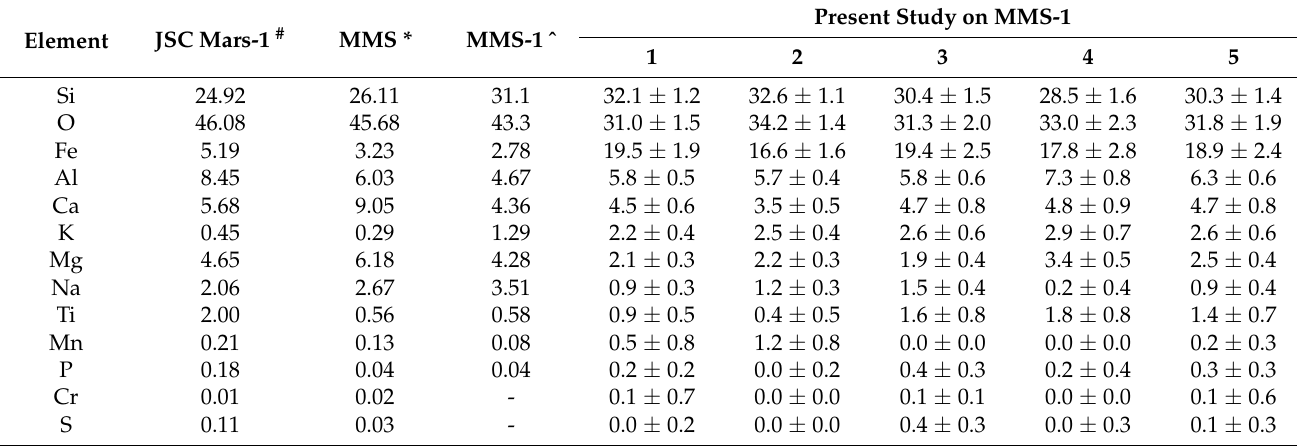
Table 1. Element weight percentages of MMS-1 grains obtained from EDS analysis in comparison with other simulants. Element JSC Mars-1